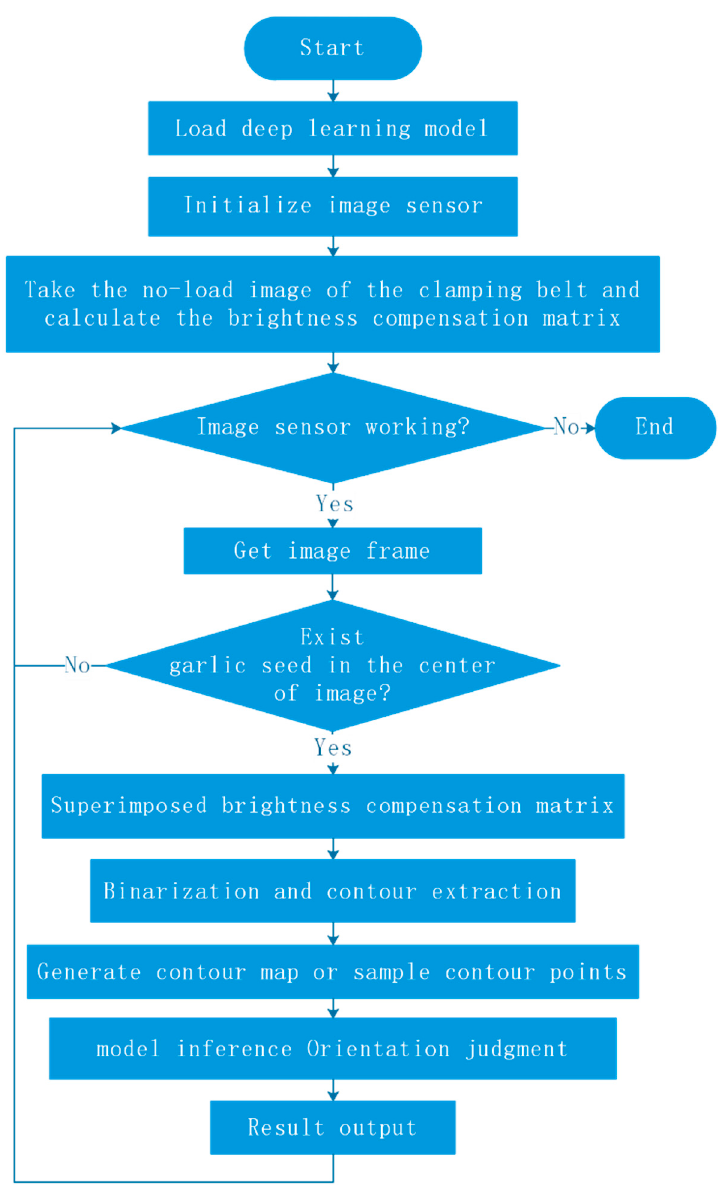
Figure 16. Flow chart of orientation judgment procedure. Under backlight illumination, it can be judged whether a garlic seed is passing by monitoring the change of the average pixel value of the central area of the camera’s field of view. Figure 17 shows the relationship between the average pixel value and the